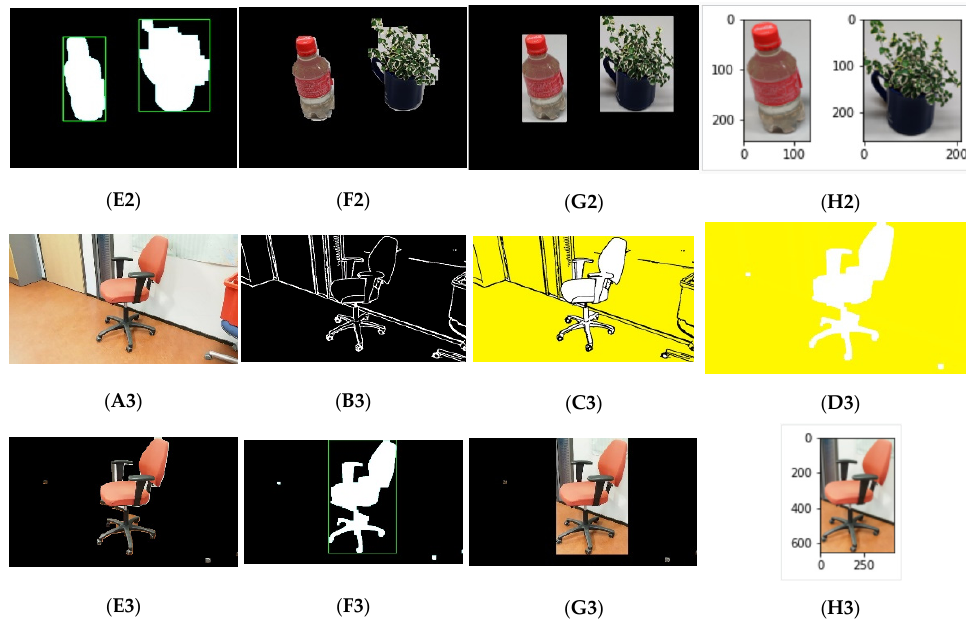
Figure 11. Experimental outcomes of the proposed unsupervised segmentation method. ( A1 – A3 ) Input image, ( B1 – B3 ) detected edges using Canny algorithm, ( C1 – C3 ) inverted image after applying enhanced Floodfill algorithm, ( D1 – D3 ) foreground of Floodfill image, ( E1 – E3 ) foreground part separated from real image using Floodfill image, ( F1 – F3 ) foreground of BoundingBox image, ( G1 – G3 ) Bitwise AND with mask BoundingBox image and main image, and ( H1 – H3 ) all segmented objects.